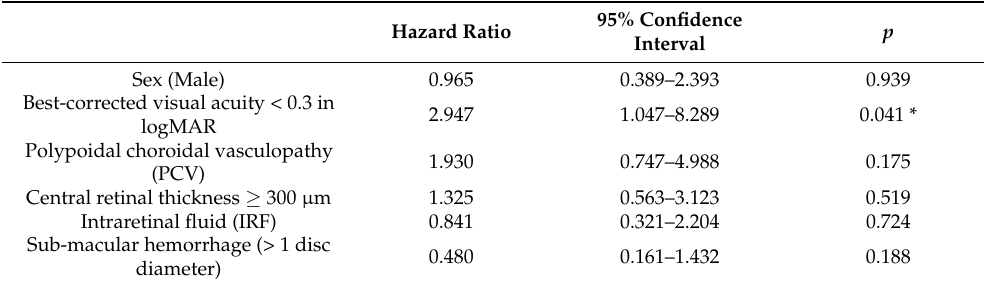
Table 4. Cox hazard ratios of factors associated with post-therapeutic maintained or improved best-corrected visual acuity.